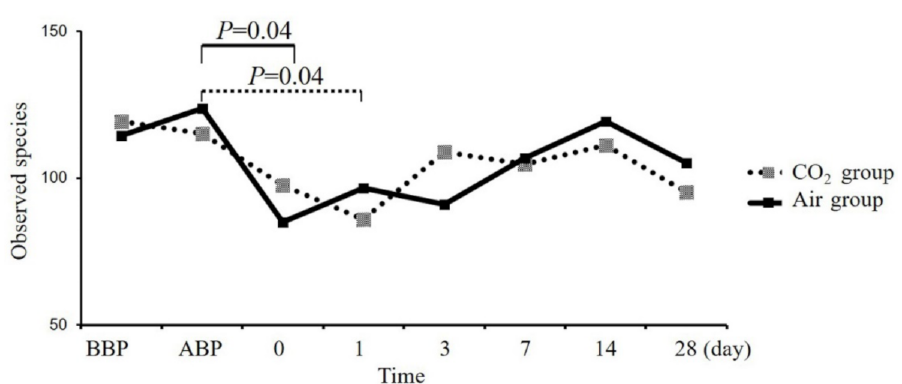
Figure 3. Changes of the species richness (alpha diversity) of gut microbiota in the CO 2 group and the air group. The species richness after colonoscopy decreased more slowly and recovered more quickly in the CO 2 group (115.0 ± 32.81 vs. 97.4 ± 42.31, p = 0.28) than in the air group (123.8 ± 37.25 vs. 84.8 ± 31.67, p = 0.04). CO 2 , carbon dioxide. BBP, before bowel preparation. ABP, after bowel preparation. 0, 1, 3, 7, 14, 28 indicates the day of the colonoscopy and 1, 3, 7, 14, 28 days after